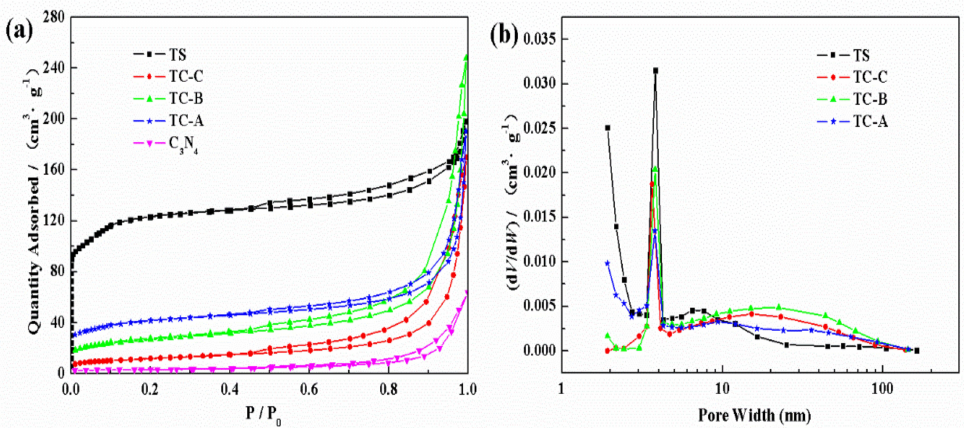
Figure 5. N 2 adsorption–desorption isotherms ( a ) and the pore-widths of TS-1, C 3 N 4 , TC-A, TC-B and TC-C ( b ).